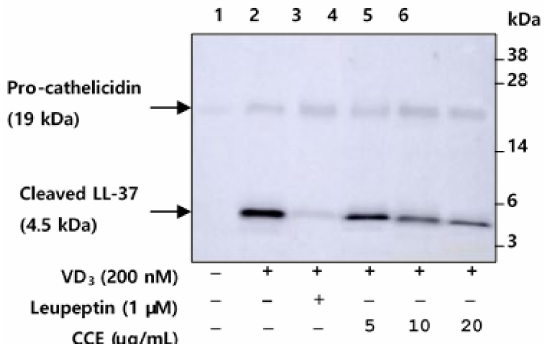
Figure 4. CCE inhibits the proteolytic cleavage of cathelicidin by inhibiting KLK5 activation. HEKn (passage 3) at 90% confluence was pretreated with 5, 10, or 20 µ g / mL CCE and 5 µ M leupeptin, a serine protease inhibitor, for 1 h, and subsequently treated with 200 nM VD 3 for 48 h. HEKn culture media was collected, and analyzed by Western blot analysis with anti-LL-37 antibody. Lane 1, DMSO vehicle control; lane 2, HEKn + VD 3 ; lane 3, HEKn + VD 3 + leuepetin; lanes 4–6, HEKn + VD 3 + 5, 10, or 20 µ g / mL CCE. Full-length blots are presented in Supplementary